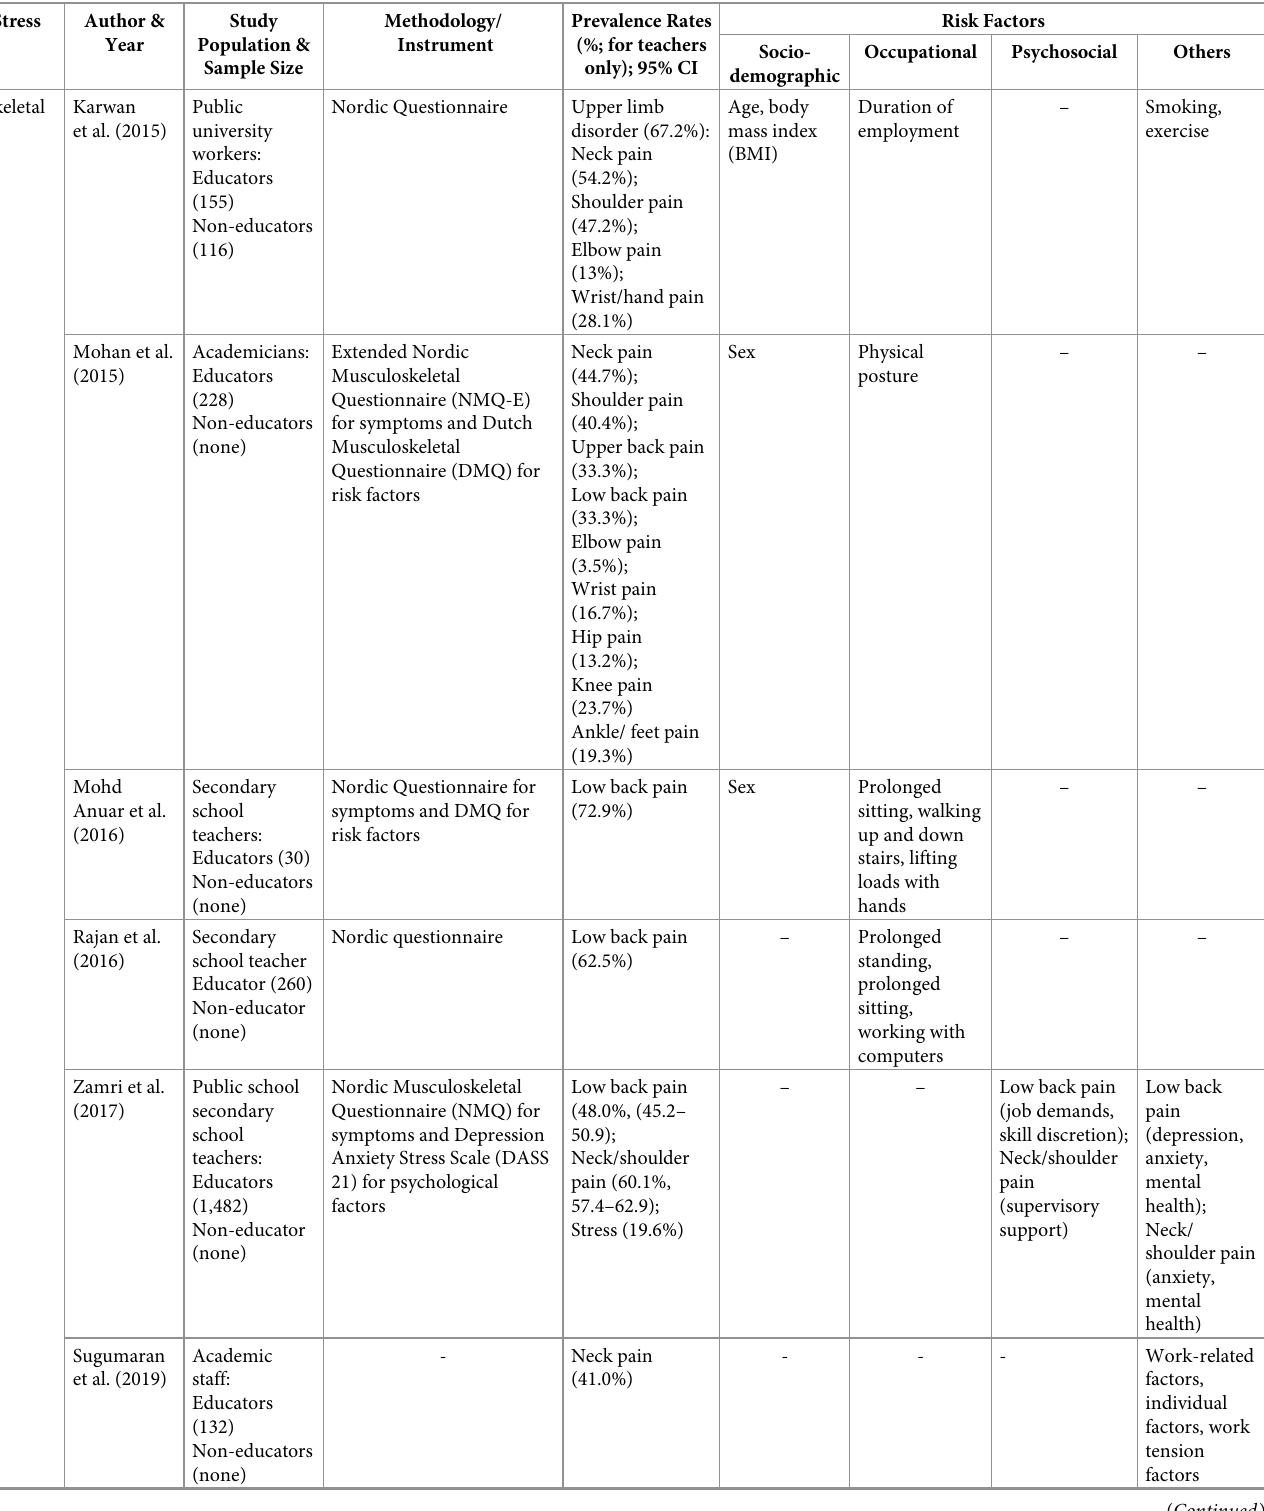
Table 3. Summary of the selected local